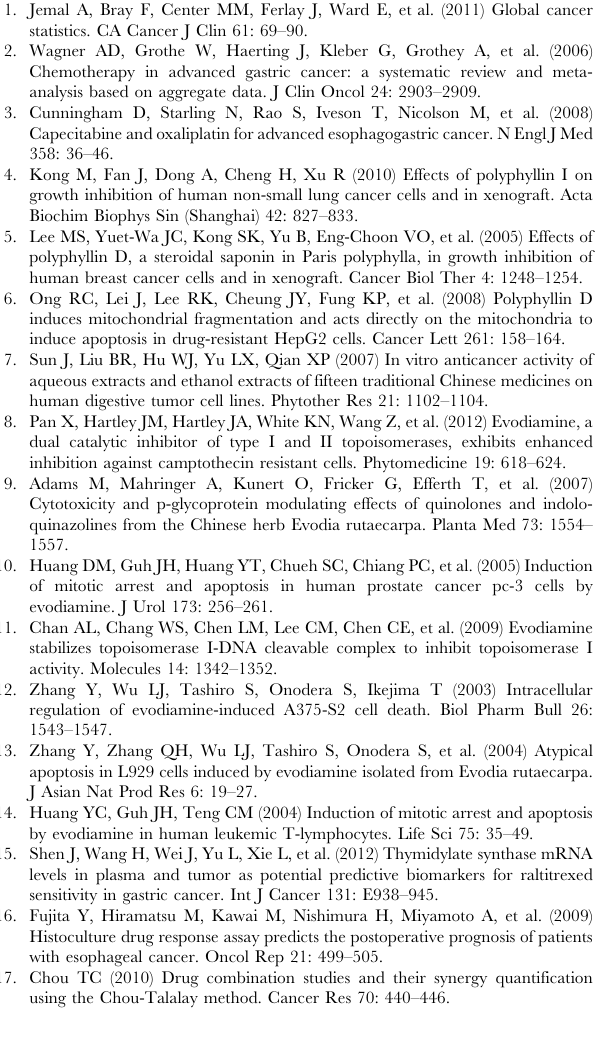
Table S1 The effects of PPI and EVO on reverse Pt resistance at different